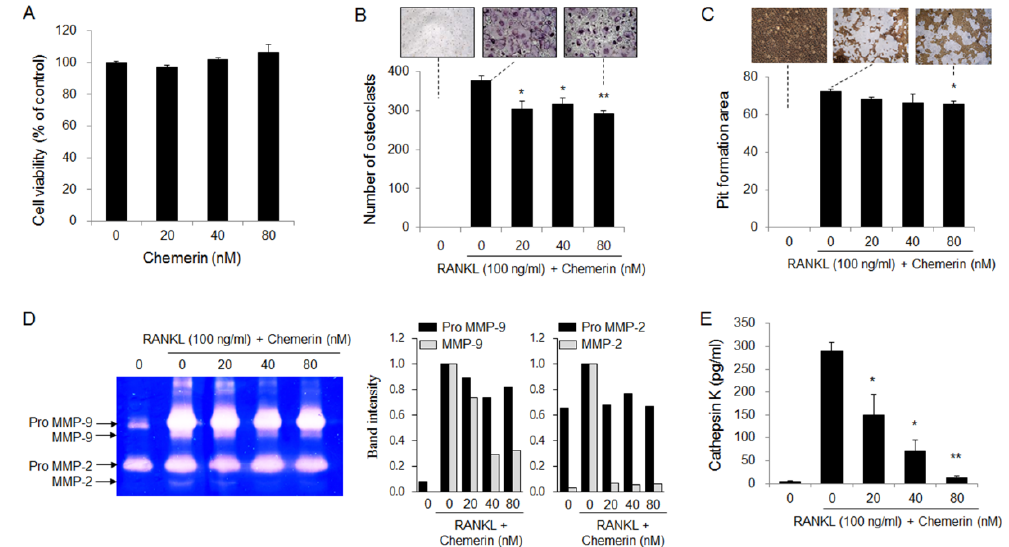
Figure 5. Chemerin slightly suppressed RANKL-induced osteoclast formation and activity in bone marrow-derived macrophages (BMMs). ( A ) The viability of BMMs treated with chemerin for 5 days; ( B ) The number of differentiated osteoclasts derived from BMMs treated with chemerin in the presence of macrophage colony-stimulating factor (M-CSF) and RANKL for 5 days. The cells were stained for tartrate-resistant acid phosphatase (TRAP), and the multinucleated (more than 3 nuclei) TRAP-positive cells were counted as osteoclasts under a light microscope. Representative images at 40 × magnification; ( C ) The formation of resorption pits by osteoclasts. Representative images at 100 × magnification; ( D ) MMP levels secreted from osteoclasts; ( E ) Cathepsin K levels secreted from osteoclasts. ( C – E ) BMMs were treated with M-CSF and RANKL in Osteo Assay Stripwell Plates for 5 days and then with chemerin in the presence of M-CSF and RANKL for an additional 2 days. BMMs were lysed, and the area of resorbed pits was calculated with IMT i-Solution software. The levels of pro and active MMP-2 and MMP-9 in the culture media were detected with gelatin zymography. Band intensities were measured with Image J software. Cathepsin K levels in the culture media were measured using an ELISA kit. Data are expressed as the mean ± SEM. * p < 0.05, ** p < 0.01 versus cells treated with RANKL alone.